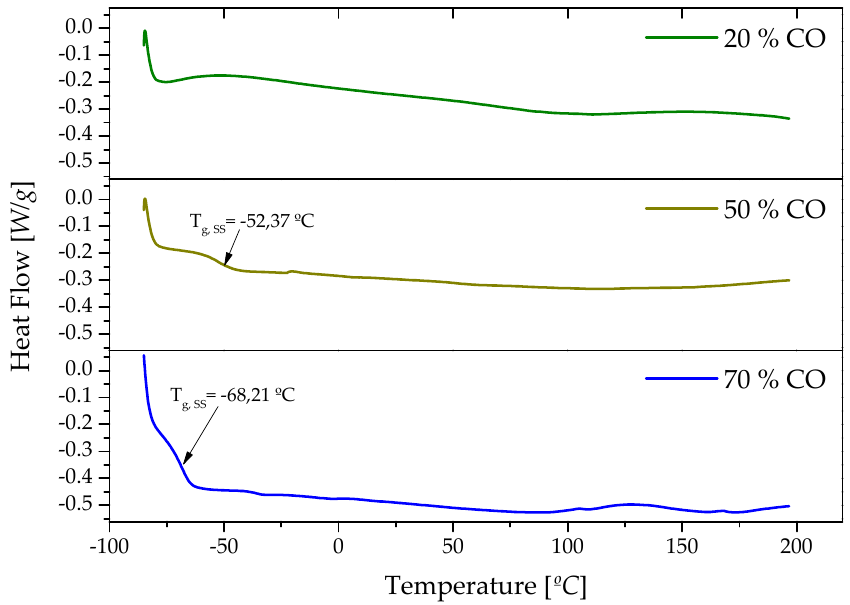
Figure 4. Differential scanning calorimetry (DSC) thermograms for bio-based polyurethane samples studied.